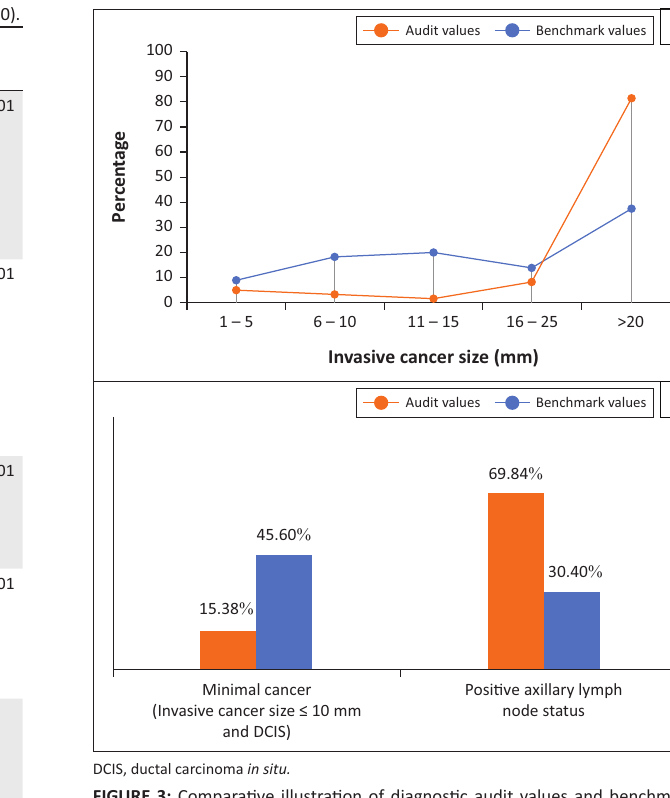
FIGURE 3: Comparative illustration of diagnostic audit values and benchmark values for cancer characteristics based on known pathological cancer size and axillary lymph node status.